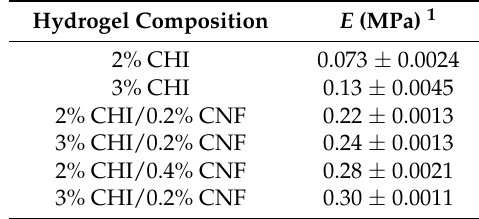
Figure 6. Stress–strain curves of CNF/CHI hydrogels of different compositions analyzed in microtensile tests performed under controlled 45% relative humidity. Table 1. Elastic modulus ( E ) values of CNF/CHI hydrogels of different compositions obtained by microtensile test.